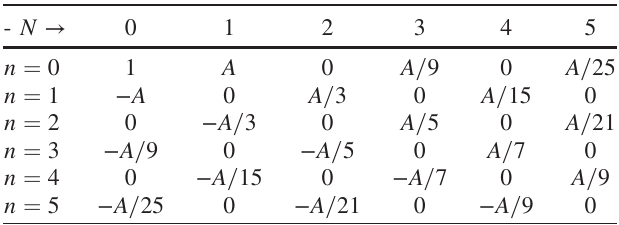
ð A ¼ 4 = π 2 N;n